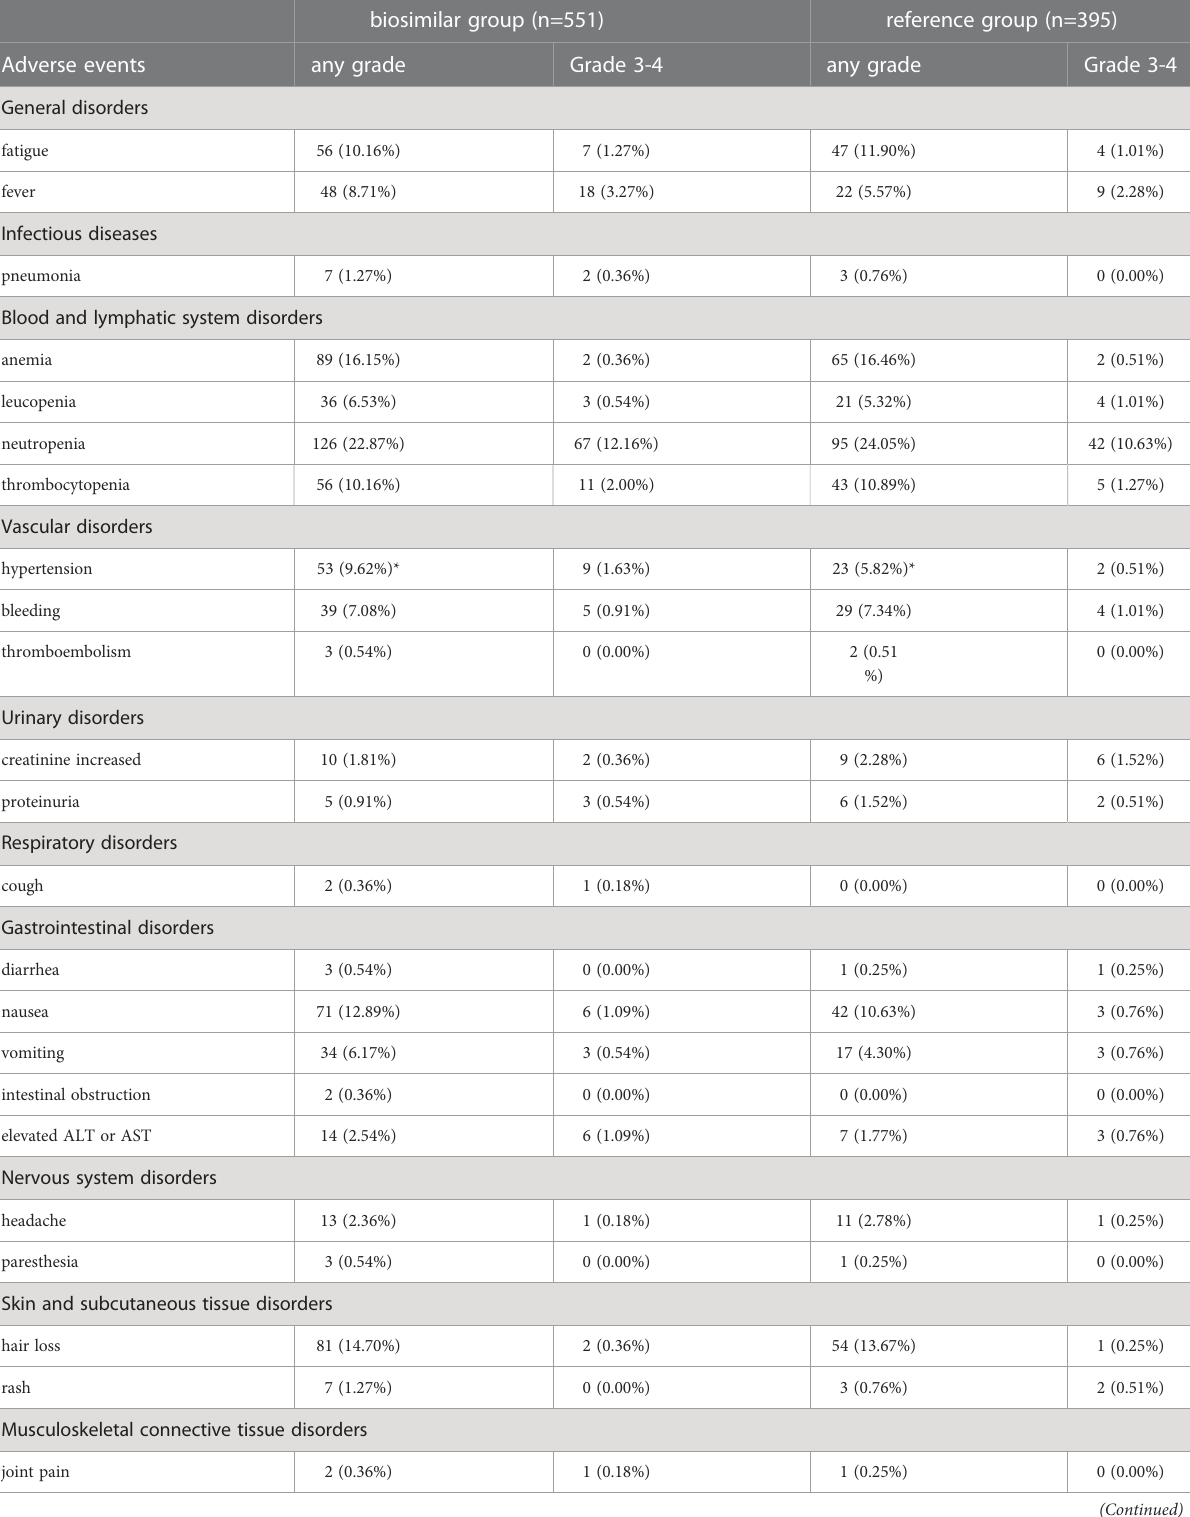
TABLE 5 Treatment-related adverse